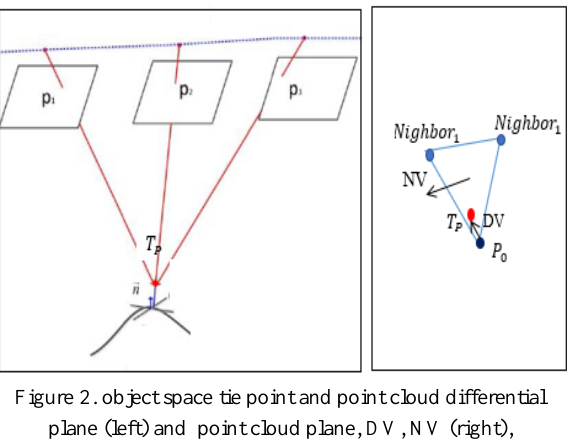
Figure 2. object space tie point and point cloud differential plane (left) and point cloud plane, DV, NV (right),